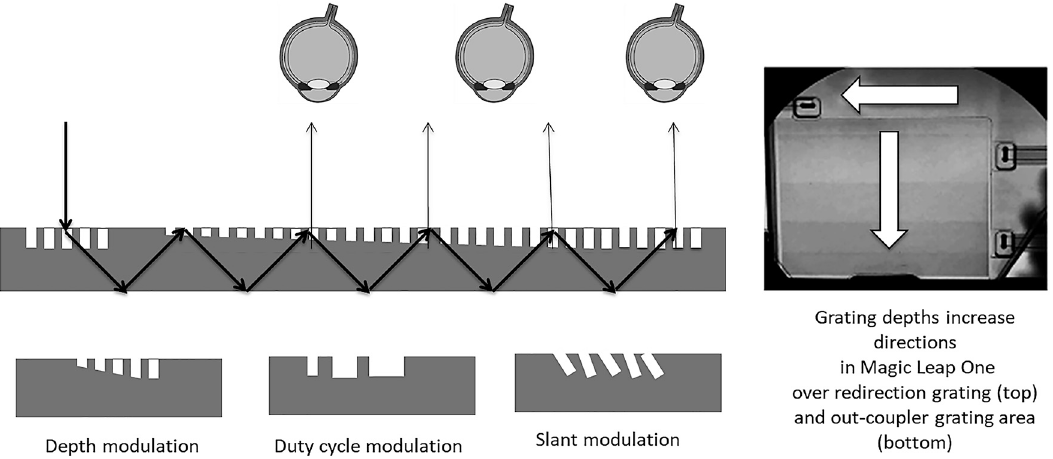
Figure 22: Modulation of the outcoupling efficiency to build up a uniform